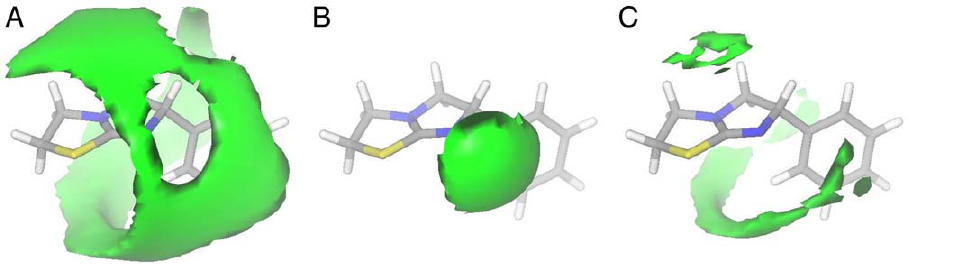
Figure 2. GRID calculated Molecular Interaction Fields (MIFs) for levamisole. The depicted conformation corresponds to the global energy minimum conformation of levamisole. A) Methyl probe, contour level –1 kcal/mol; B) amide nitrogen probe, contour level –5 kcal/mol; C) carbonyl oxygen probe, contour level –1 kcal/mol.